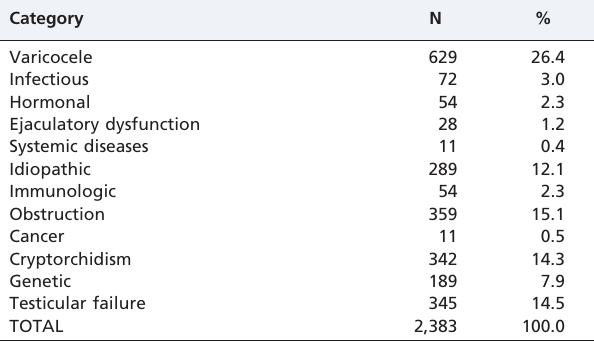
ANDROFERT, Campinas –